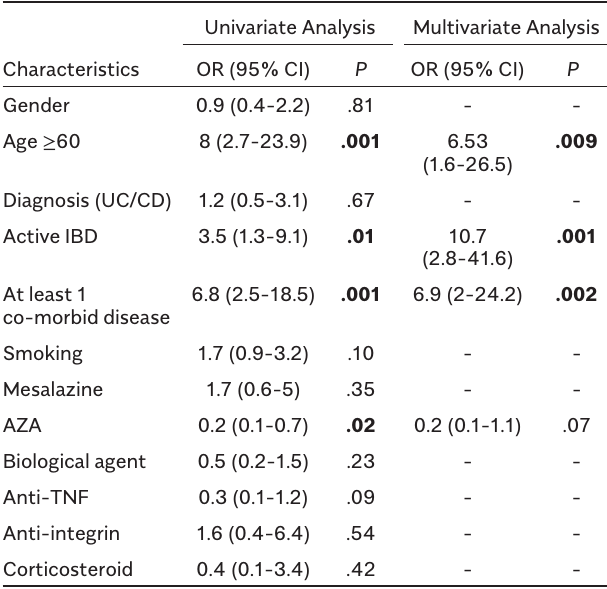
Table 4. Univariate and Multivariate Regression Analysis for Risk of Severe COVID-19 Univariate Analysis Multivariate Characteristics